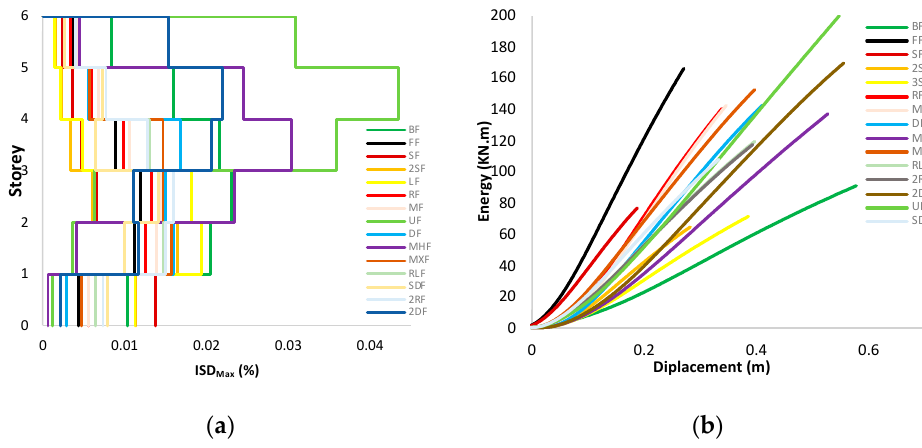
Figure 7. The structural response: ( a ) maximum ISD for each story for the cases studied; ( b ) plastic